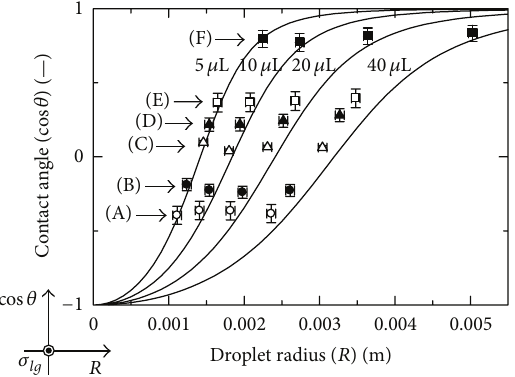
Figure 5: Relationship between droplet radius and contact angle.